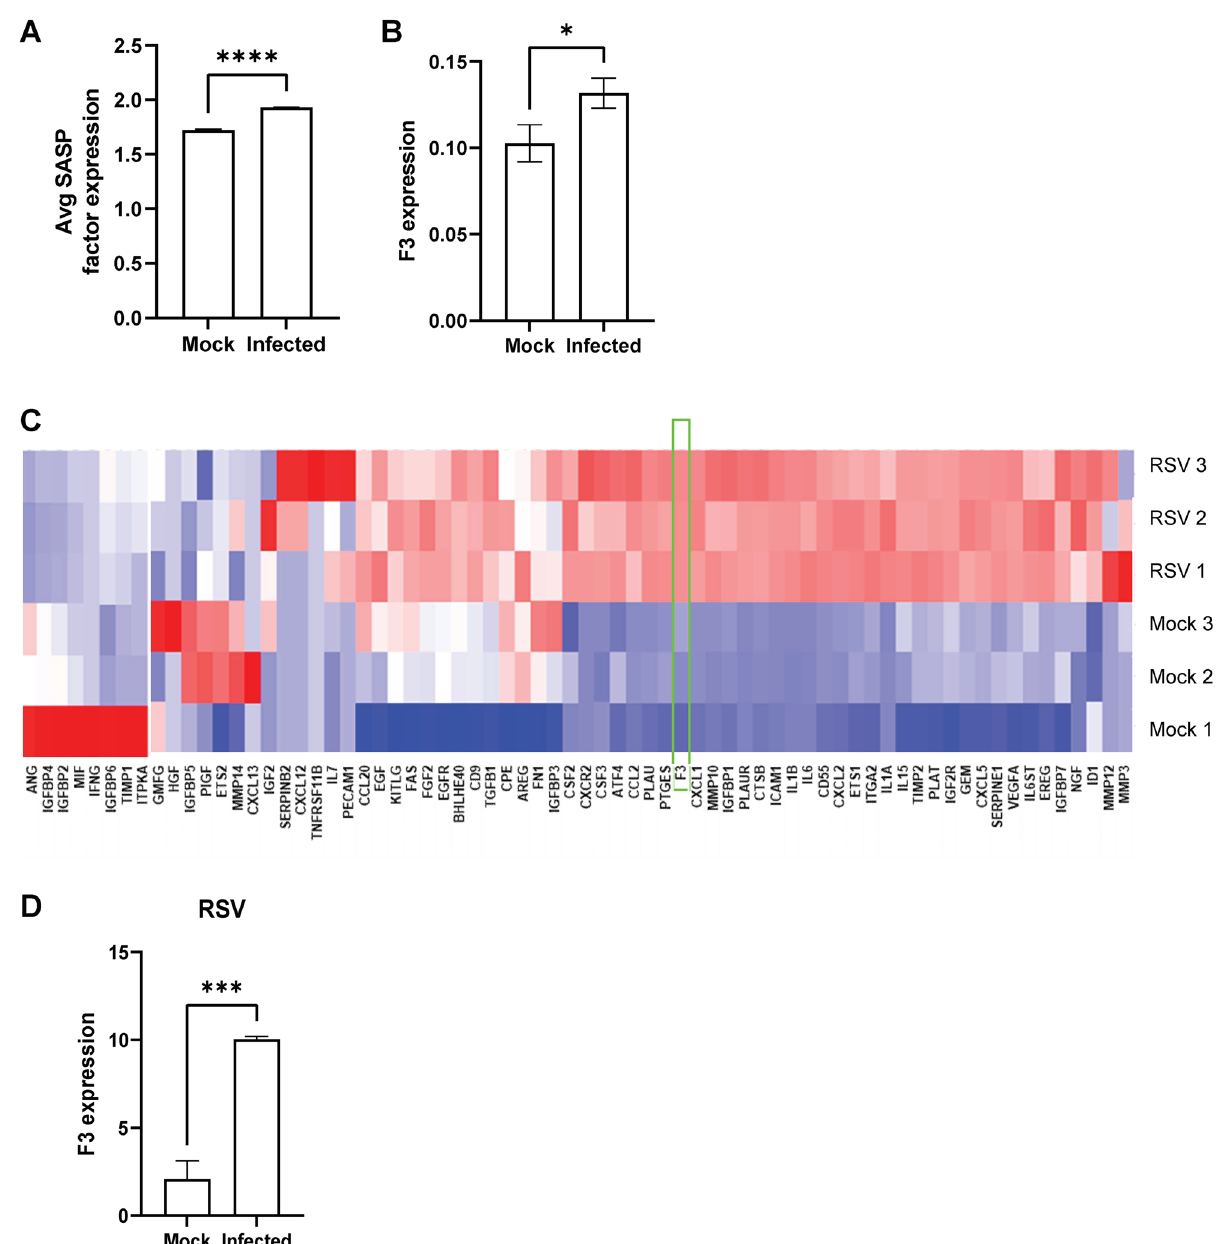
Figure 5. SASP factors and F3 are upregulated upon RSV and IAV infection. ( A ) The levels of representative SASP factor expression in IAV infected A549 cells. ( B ) F3 expression in A549 cells infected with IAV (mock, n = 1; IAV n = 3). * p value < 0.05. ** p value < 0.005. ( C ) Heat map plot of the SASP factor expression in the Mock and RSV-infected A549 cells ( n = 3 per group). ( D ) F3 expression in RSV-infected A549 cell lines. ** p value <